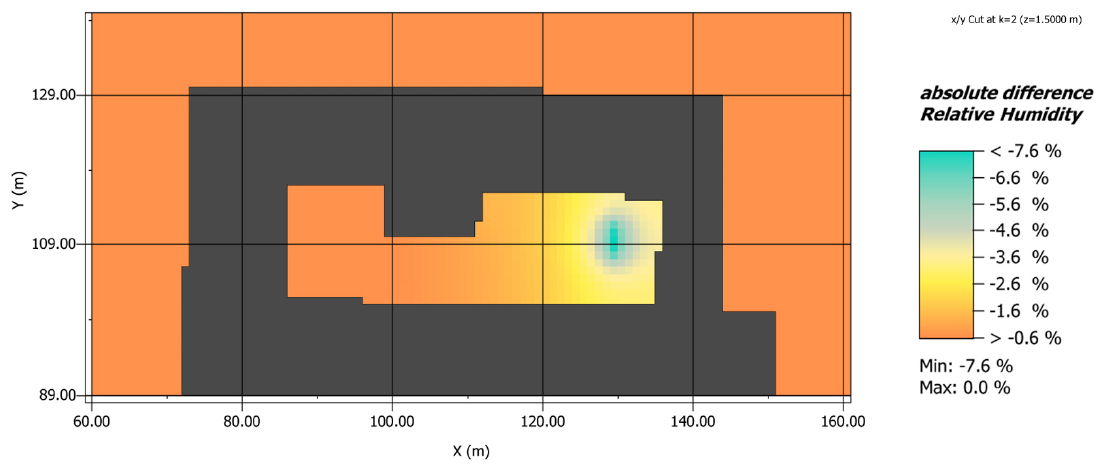
Figure 7. The comparison of initial state with reference water curtain scenario relative humidity at the height of 1.5 m. Figure by authors.